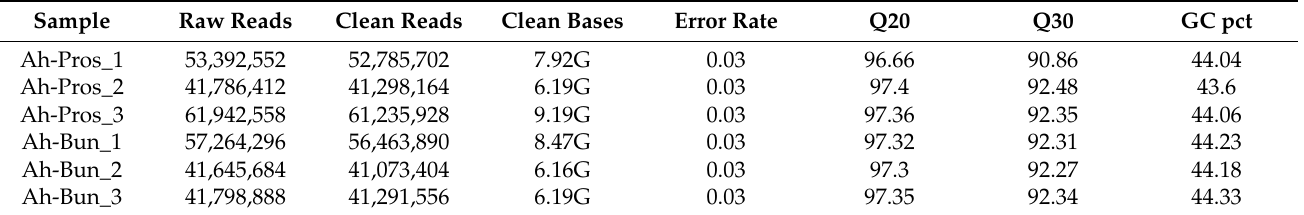
Figure 2. Phenotypic variations of prostrate and bunch growth habits in the F3 lines of TI population ( A ) phenotype of bunch-type peanut demonstrating bunch growth habit ( B ) Phenotype of prostrate- type peanut demonstrating prostrate growth habit ( C ) Variations in lateral branch angle of prostrate and bunch F3 lines selected for construction of RNA pools. Table 1. Overview of the total read numbers from the F3 lines of C population derived from (Tifrunner × Ipadur)